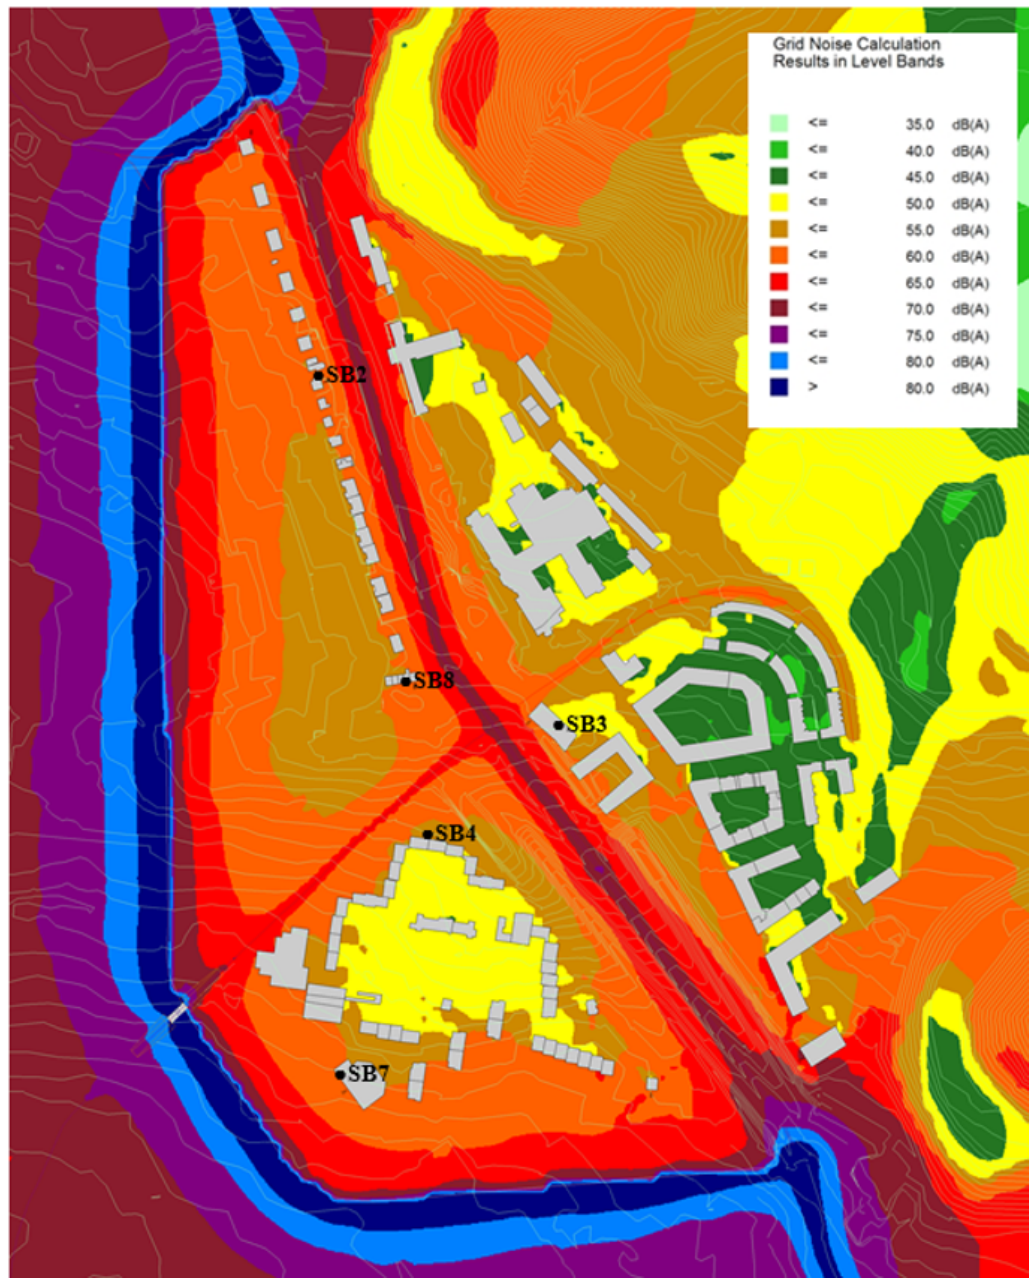
Figure 3: Calculated levels for variant with construction of a bypass - reference time interval – day